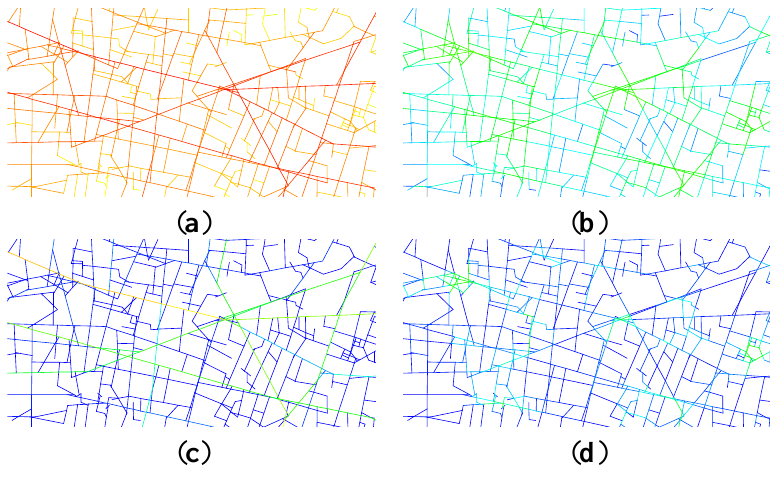
Figure 2. Segment angular maps of the centre of London. ( a ) Global integration. ( b ) Local integration. ( c ) Global choice. ( d ) Local choice. The maps are coloured from red (representing a more integrated space) to blue (a more segregated